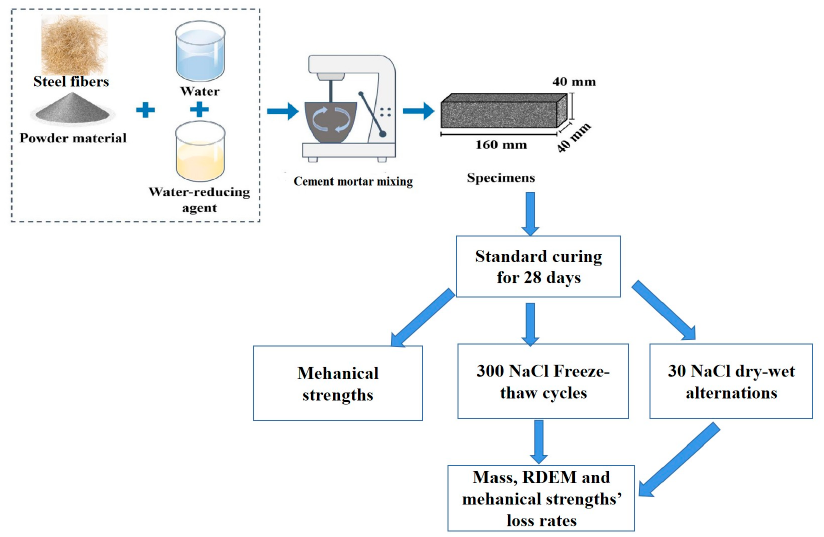
Figure 1. The manufacturing and measuring processes. Table 3. Mix proportion of RPC per unit volume (kg/m 3 ).